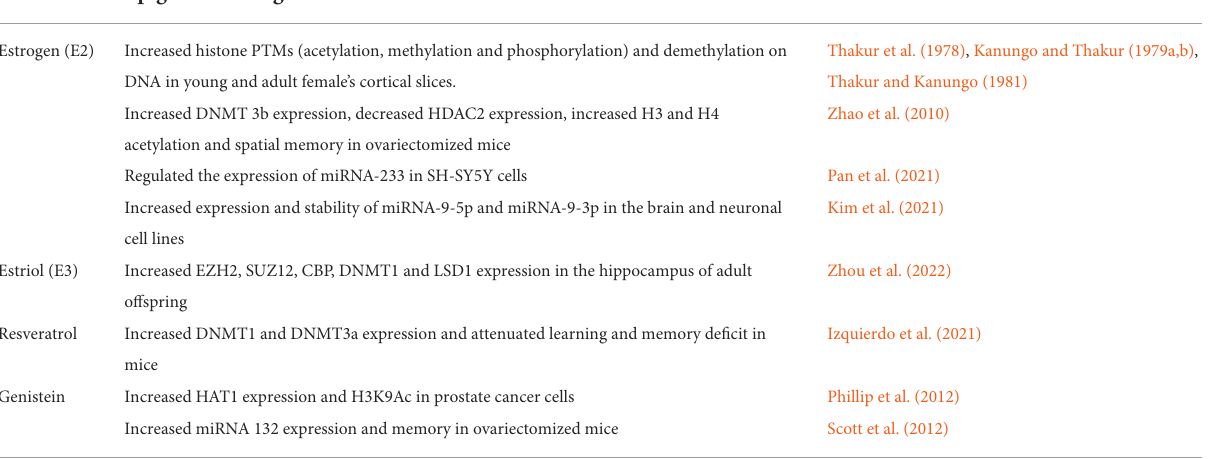
TABLE 1 List of epigenetic mechanisms regulated by